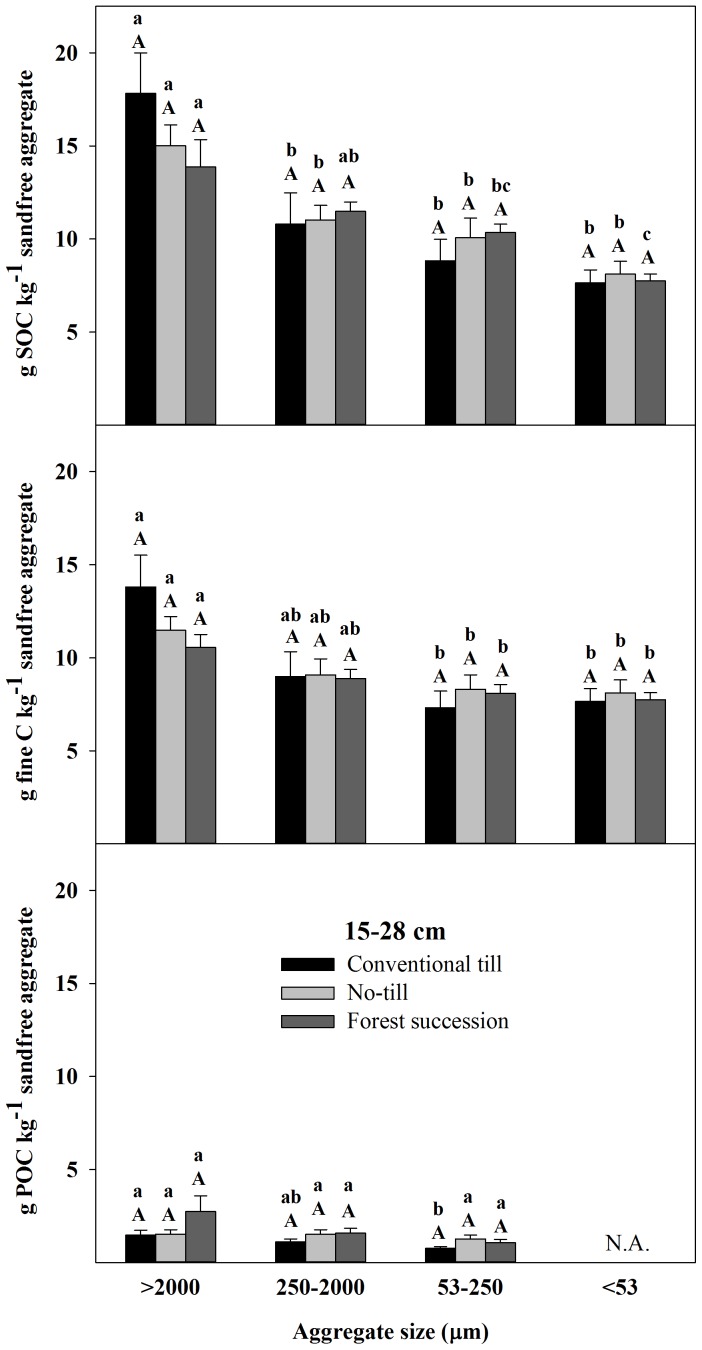
Total soil organic C (SOC), fine C (<53 µm), and particulate organic C (POC) (53–2000 µm) concentrations on a sand-free basis from 15–28 cm in four different aggregate size fractions (mean ±1 SE) in the Horseshoe Bend Agroecosystem Experiment (n = 4) Athens, GA, USA, October 2007.Different uppercase letters within an aggregate size class and C fraction represent a significant difference between land uses. Different lowercase letters within a C fraction and a land use represent a significant difference among aggregates size classes (α = 0.05). See also Table S5, part 1 and Table S5, part 2.